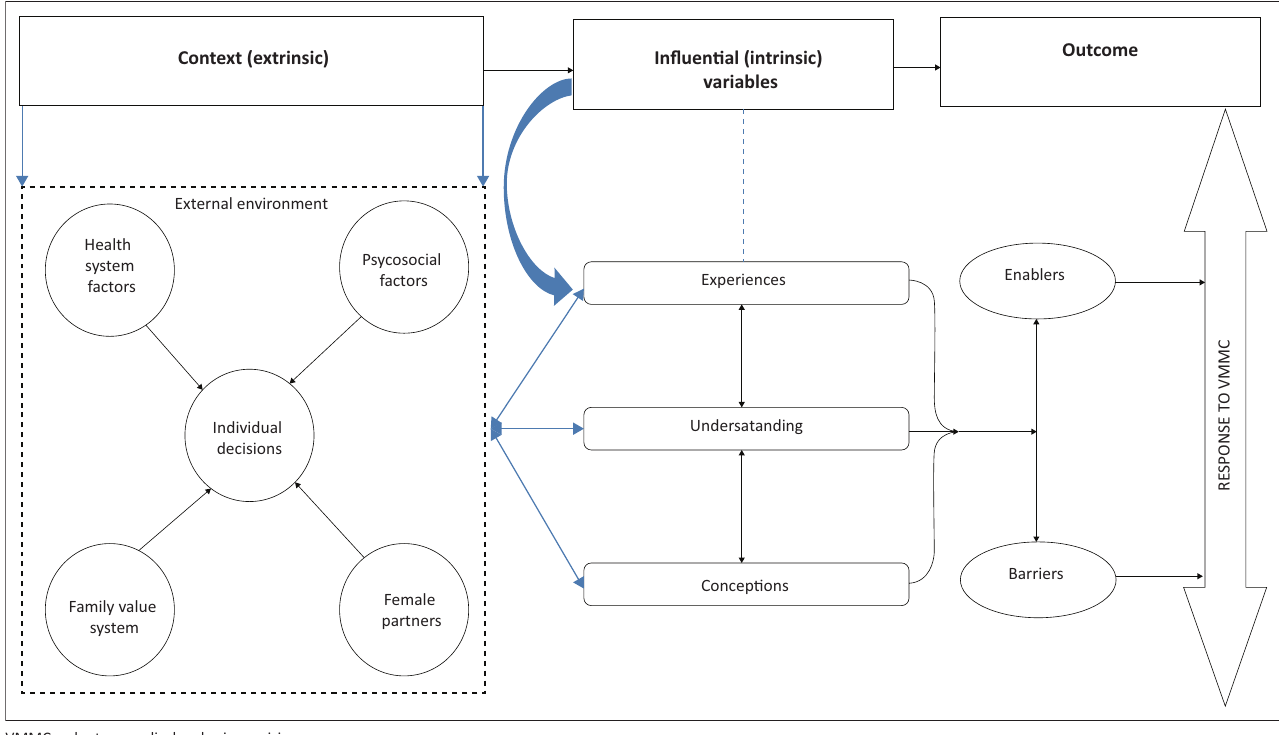
FIGURE 2: Proposed explanatory model of voluntary medical male circumcision in KwaZulu-Natal, South